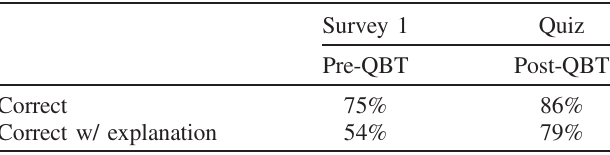
TABLE IV. Percentage of students answering that changing the state to the x basis does not change the probabilities for measurements in the z direction (Q2 in Fig. 5). Pretest and post-test results are shown with 23 matched students, represent- ing 92% of the students enrolled in the course. All students provided some explanation.